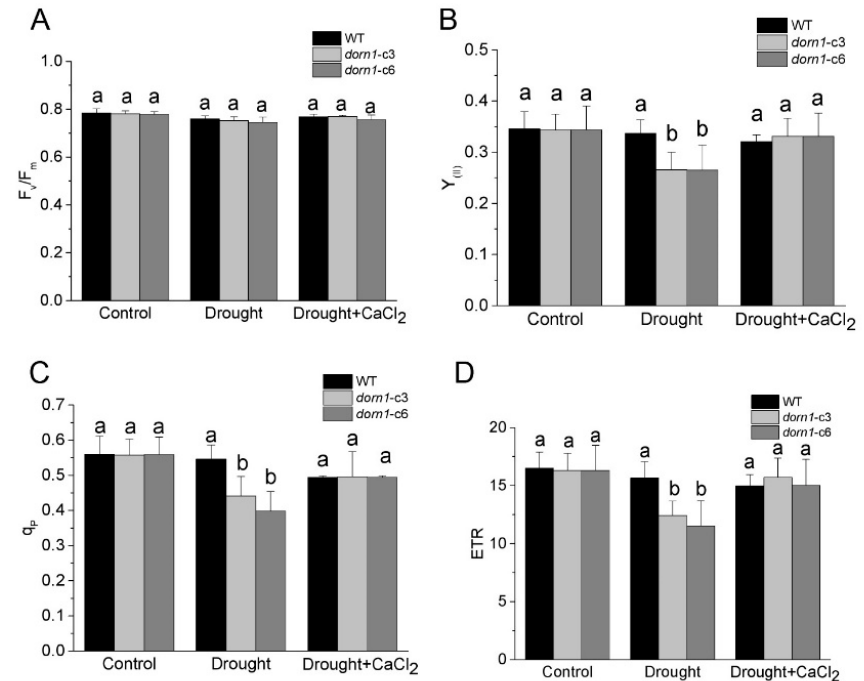
Figure 3. Effects of CaCl 2 on the photochemical reaction performance of the dorn1 plant under drought stress. Effects of CaCl 2 on the performance of F v /F m ( A ), Y (II) ( B ), q P ( C ) and ETR ( D ) in the dorn1 mutant and WT plants. The treatment group was pre-treated by spraying 1 mM CaCl 2 once a day for three days. Different letters indicate significant differences ( p < 0.05) using ANOVA analysis. Each data point represents the average data of ~15 seedlings of three duplicate experiments, and error bars represent the standard deviation (SD).